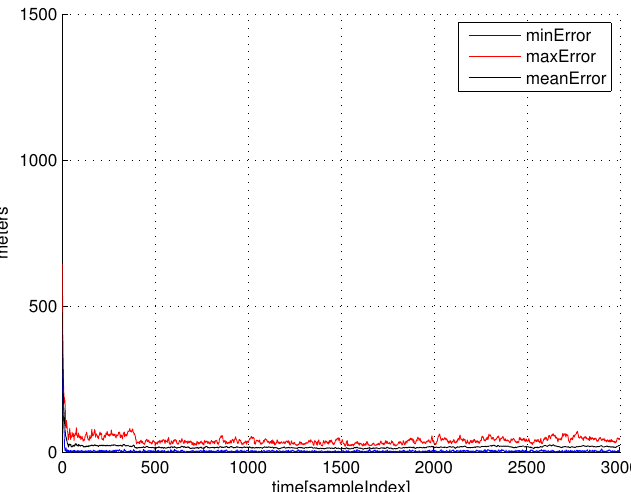
Figure 4. Consider the case where the proposed localization method is utilized. We plot meanE k , maxE k , and minE k with respect to sample-index k . See that the estimation error decreased considerably, compared to Figure 2. This is due to the fact that the AUV localization uses three bearing lines emitted from three ships, instead of one bearing line emitted from one ship. (three ships scenario).